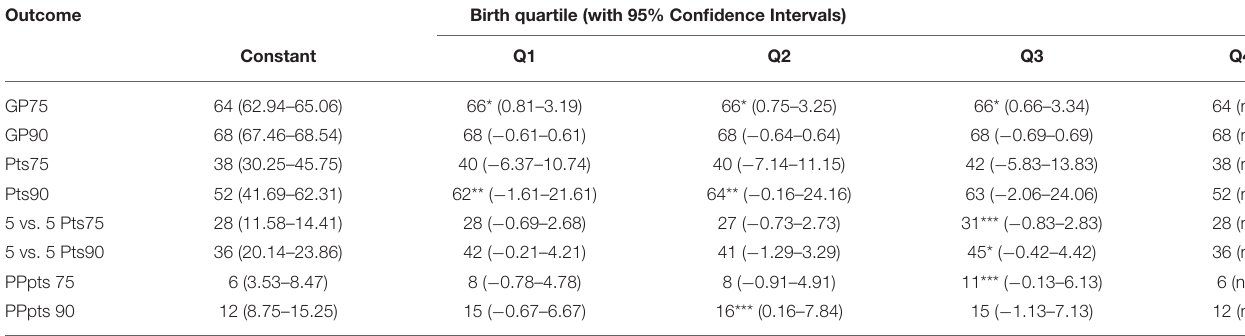
TABLE 6 | Birth quartile and performance in the CHL: Results from quantile regression.